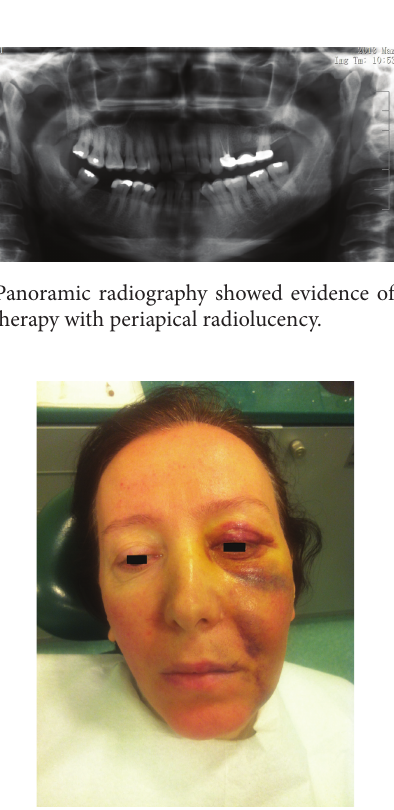
Figure 3: An increase in the ecchymosis was noticed on the first recall.